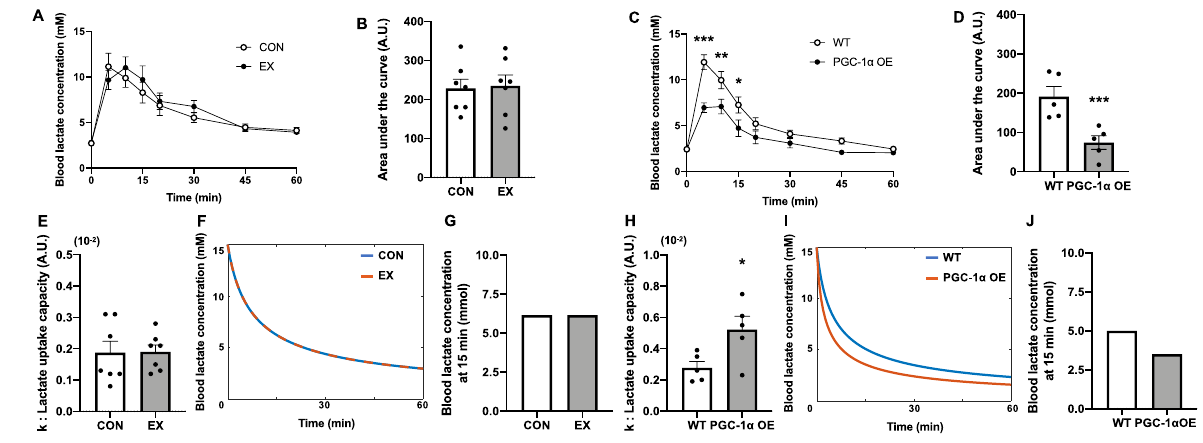
Figure 1. Effects of endurance exercise training and PGC-1α overexpression on lactate uptake capacity. Time course and area under the curve of blood lactate concentration during lactate tolerance test after 6 weeks of endurance exercise training ( A , B ) and skeletal muscle-specific PGC-1α overexpression ( C , D ). The values of k, which indicate lactate uptake capacity ( E , H ). Simulation of blood lactate concentration decay from 15 mM using the mean values of k in each group ( F , I ) and simulated blood lactate concentration at 15 min ( G , J ). Data are expressed as mean ± SEM. n = 7 in the CON and EX groups. n = 5 in the WT and PGC-1α OE groups.